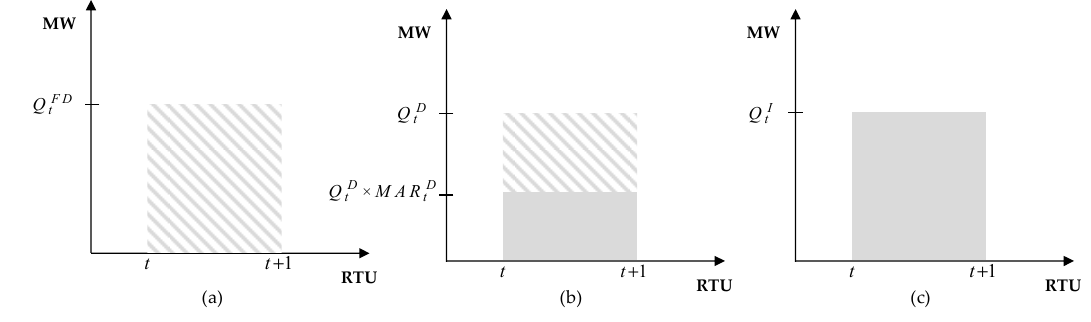
Figure 4. ( a ) Fully divisible order; ( b ) divisible order; ( c ) indivisible order.